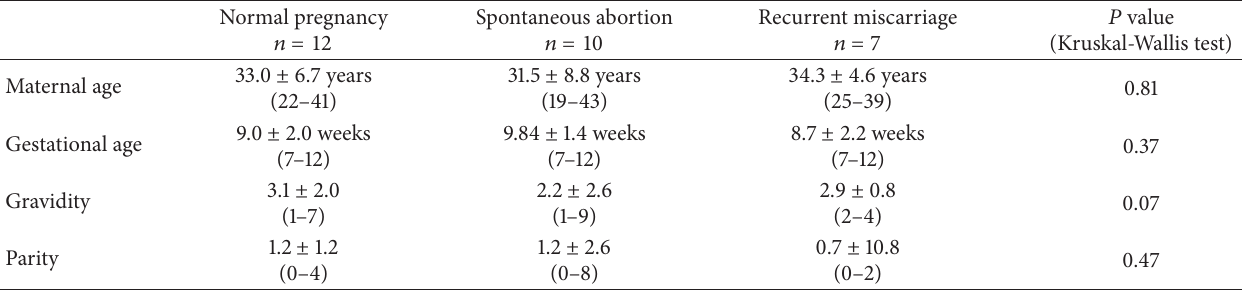
Table 1: Clinical characteristics of the study